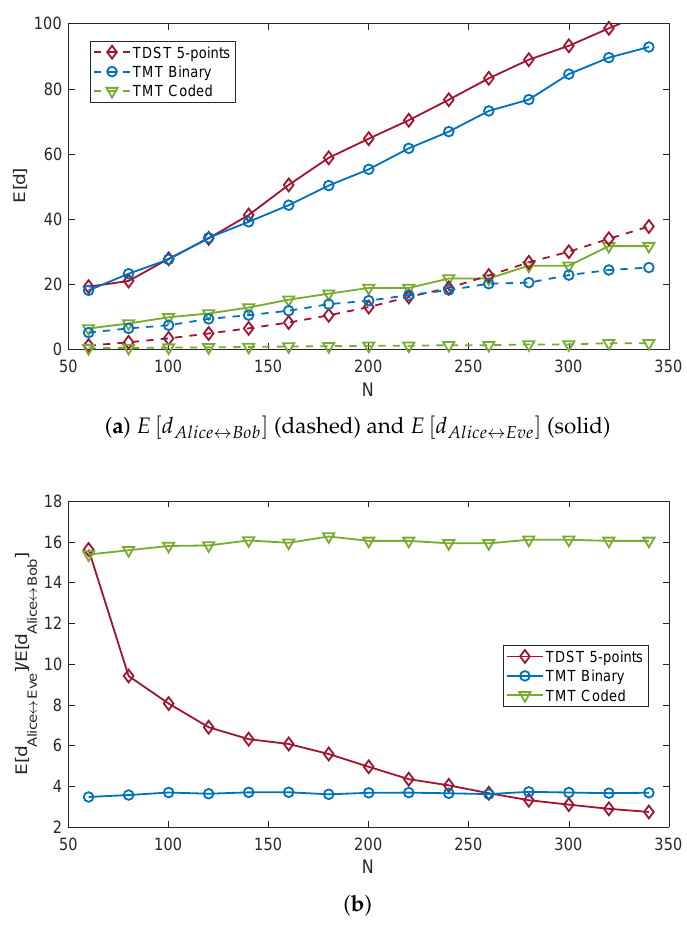
Figure 12. E [ d ] of the keys computed by Alice, Bob, and Eve ( a ) and their ratios ( b ), for different code lengths N and quantization methods. The ADC resolution is fixed to eight